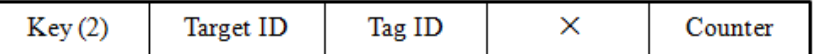
Figure 9. RFID tag’s format for inter-cluster